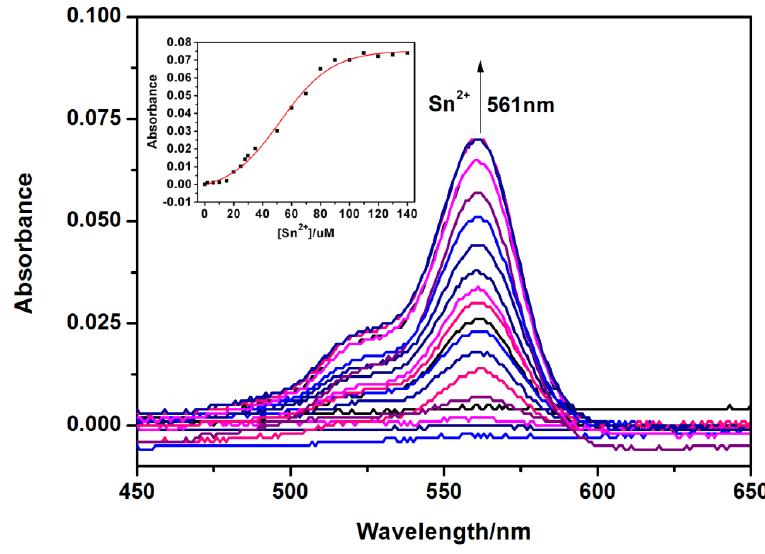
(2:3, v/v, pH 5.95) solutions containing various amounts of Sn 2+ ions (0–15 eq.). Inset: Absorbance of RBAP at 561 nm as a function of Sn 2+ concentration.